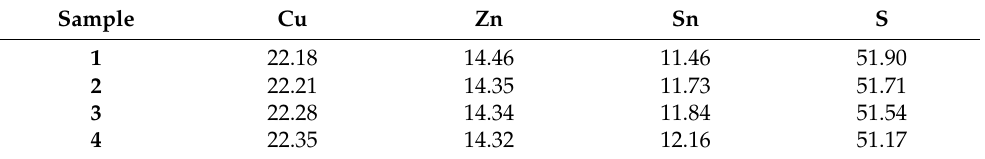
Figure 2. SEM top and cross-sectional views of CZTS − 1, CZTS − 2, CZTS − 3, and CZTS − 4. Table 1. Atomic percentages of CZTS − 1, CZTS − 2, CZTS − 3, and CZTS −